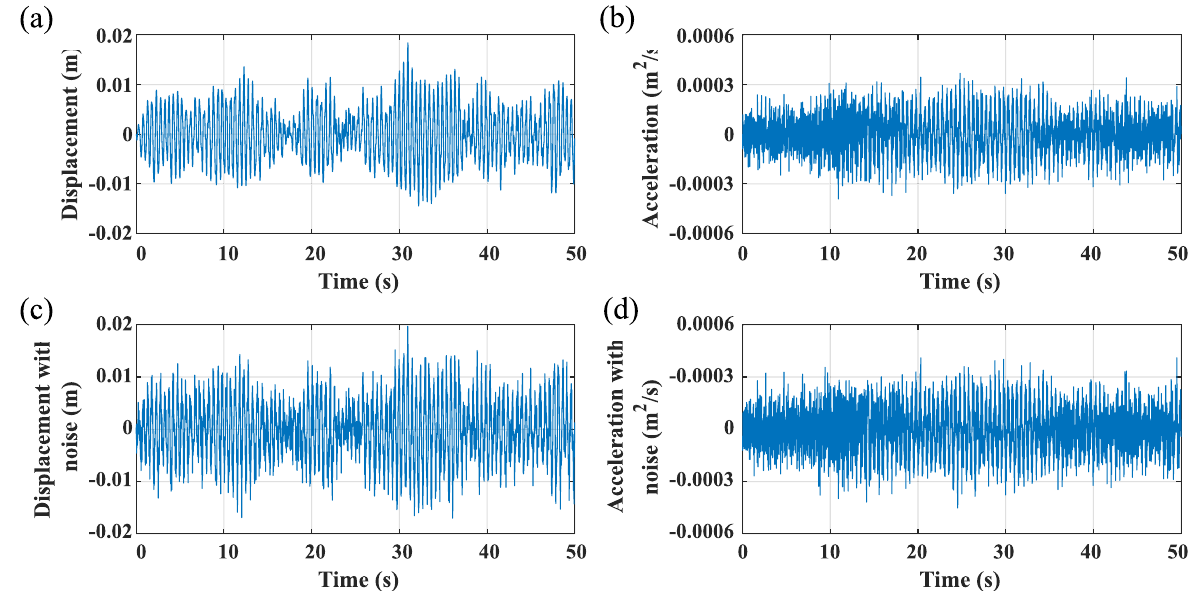
Fig. 4 Displacement and acceleration of a four-DOF model under colored noise excitation: ( a ) original displacement response; ( b ) original acceleration response; ( c ) displacement response with added noise; ( d ) acceleration response with added